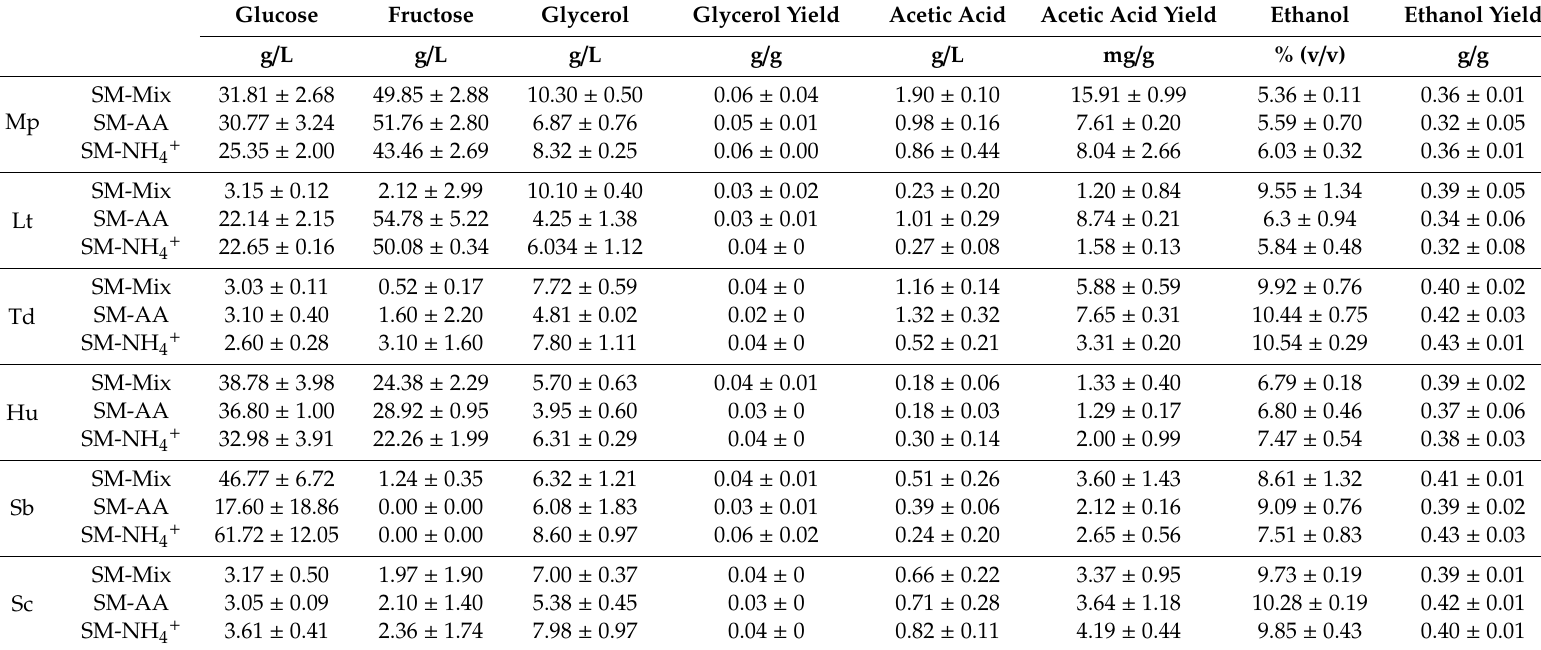
Table 2. Concentration of compounds of oenological interest at the end of each single fermentation under three nitrogen conditions (SM-Mix, SM-NH 4 + , and SM-AA) for each yeast species: M. pulcherrima (Mp), L. thermotolerans (Lt), T. delbrueckii (Td), H. uvarum (Hu), S. bacillaris (Sb), and S. cerevisiae